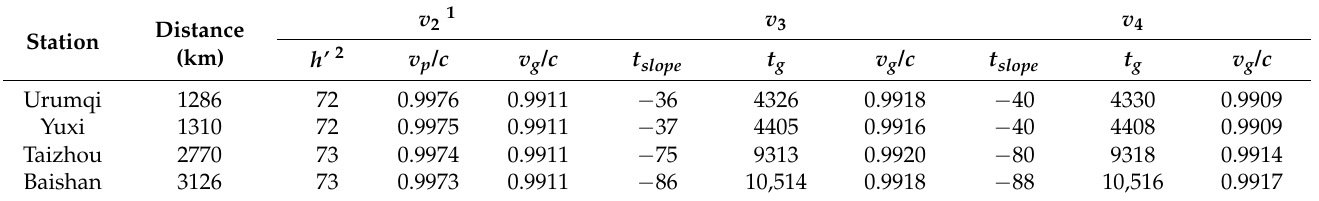
Table 2. Intermediate and final calculation results of different methods of group velocity estimation.